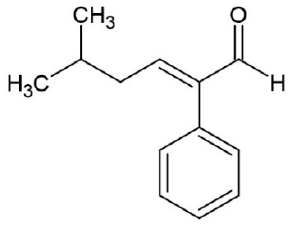
Figure 7. Structure of 2-phenyl-5methyl-2-hexenal.